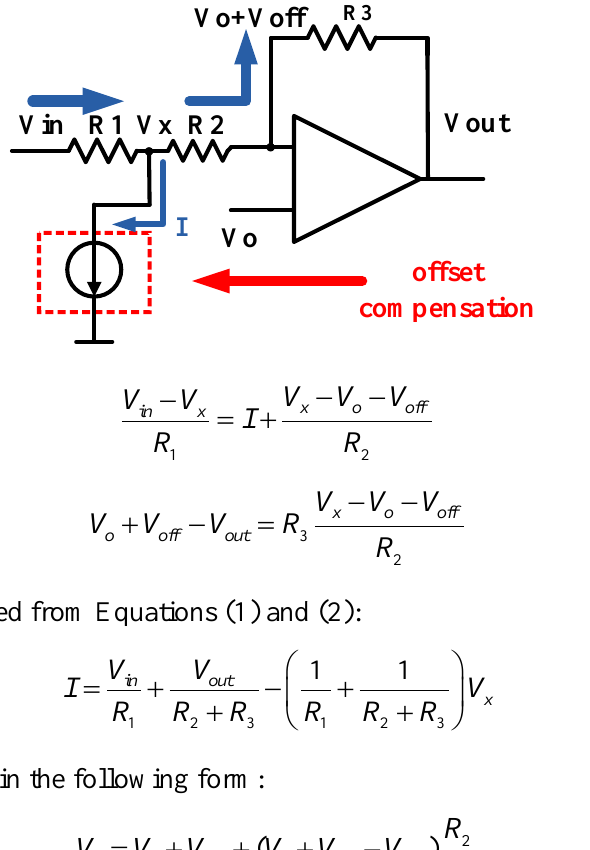
Figure 5. Offset correction circuit diagram. The additional current source provides a small quantity of current I to correct the offset, so that the amplifier’s output can be much closer to the ideal